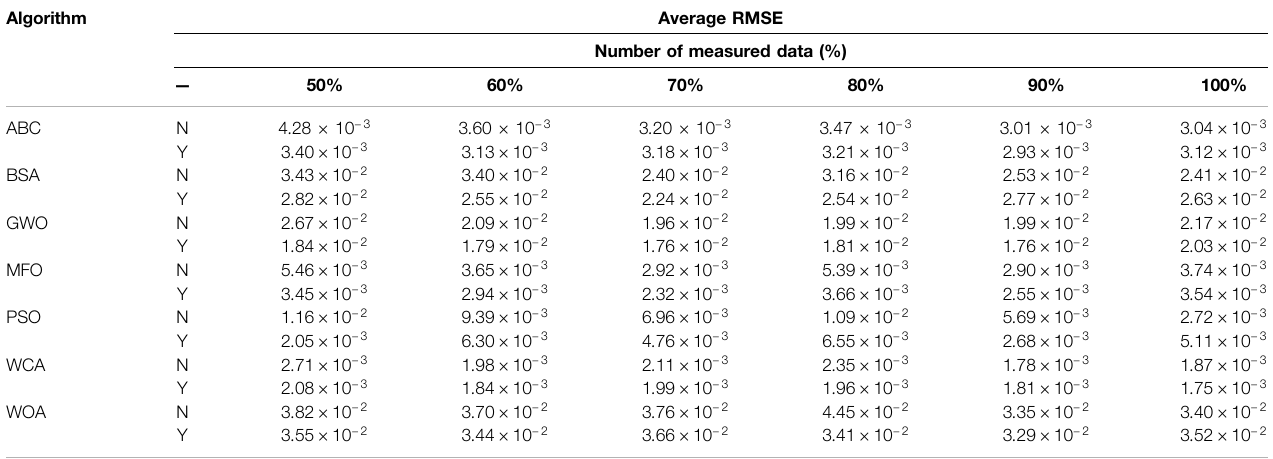
TABLE 3 | Average RMSE obtained by various algorithms for the SDM with six measured data. Algorithm